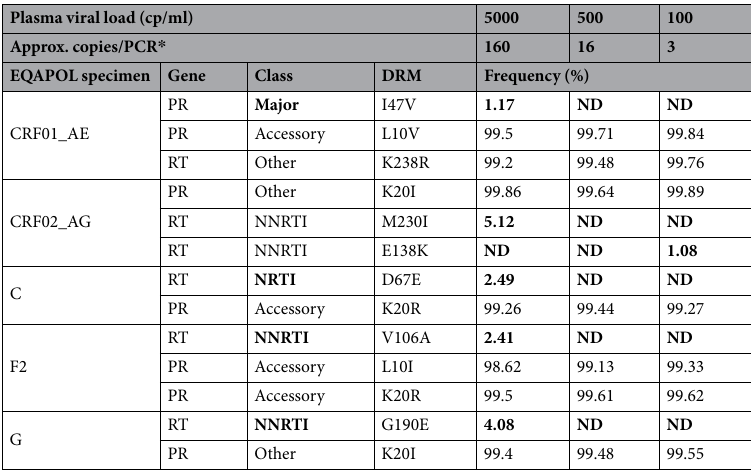
Table 5. Effect of viral load and PCR copy number on the detection of LADRVs by the MiSeq-HyDRA platform. SDRMs are in bold . * Approximate viral RNA copies per PCR reaction were calculated based on an assumed extraction efficiency of